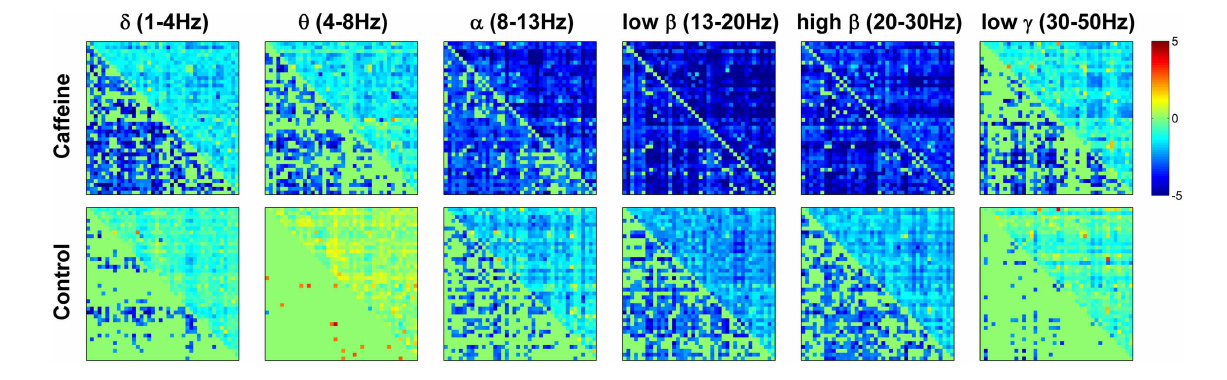
FIGURE 3 | Changes in mean connectivity (eyes closed condition) between all ROI pairs averaged across the subject group for each of the six MEG frequency bands of interest: δ (1–4Hz), θ (4–8Hz), α (8–13Hz), low β (13–20Hz), high β (20–30Hz), and low γ (30–50Hz). Each subplot is